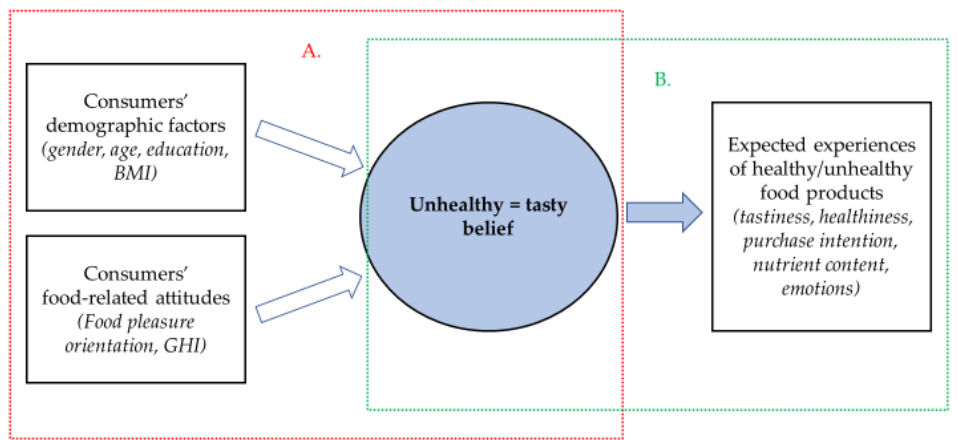
Figure 1. Study scheme. A = The first aim of the study: to specify the strength of unhealthy = tasty belief and to profile consumers according to their unhealthy = tasty belief. B = The second aim of the study: to investigate the effect of unhealthy = tasty belief on the expected experiences of food products that have typically different health images.